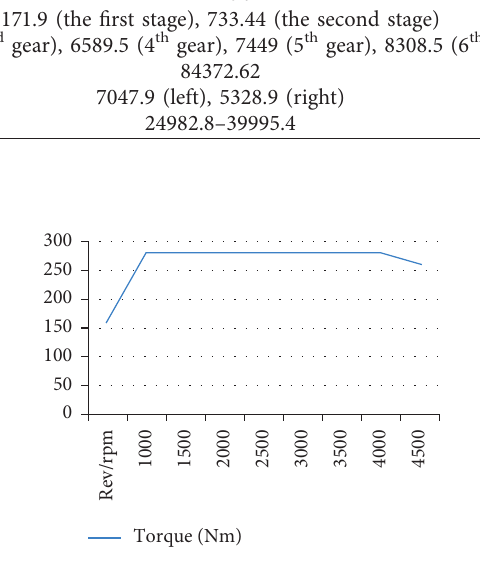
Figure 6: Engine torque